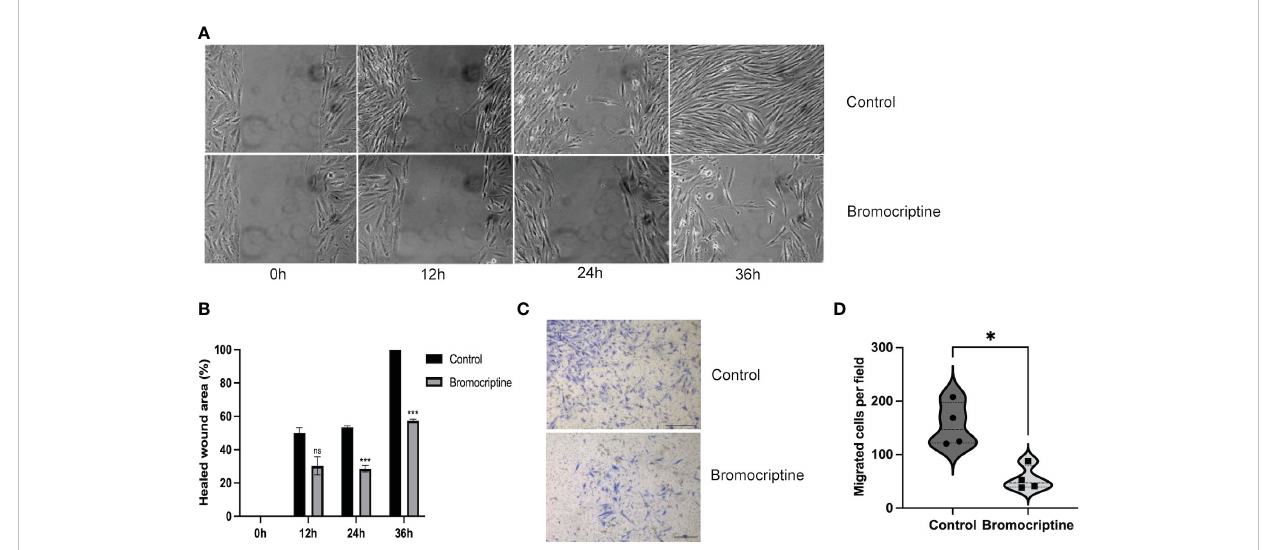
FIGURE 4 Effect of bromocriptine on cell migration ability. (A) Representative bright- fi eld images of the wound healing area at 0h, 12h, 24h, and 36h (Magni fi cation of 20×). (B) Statistical analysis of healed wound area in bromocriptine and control groups. A dose of 113.3 m M bromocriptine treatment signi fi cantly inhibited the cell ’ s horizontal migratory ability at 24h and 36h. (C) Representative images of the bottom surface of a transwell migration assay in endometrial stromal cells (Magni fi cation of 4×, scale bar:500 m m). (D) Quanti fi cation of migrated cells. The number of migrated cells in the bromocriptine group reduced signi fi cantly compared to the control group. The analysis and plot were generated by GraphPad 9.0. * P < 0.05, *** P < 0.001, ns indicates no signi fi cant